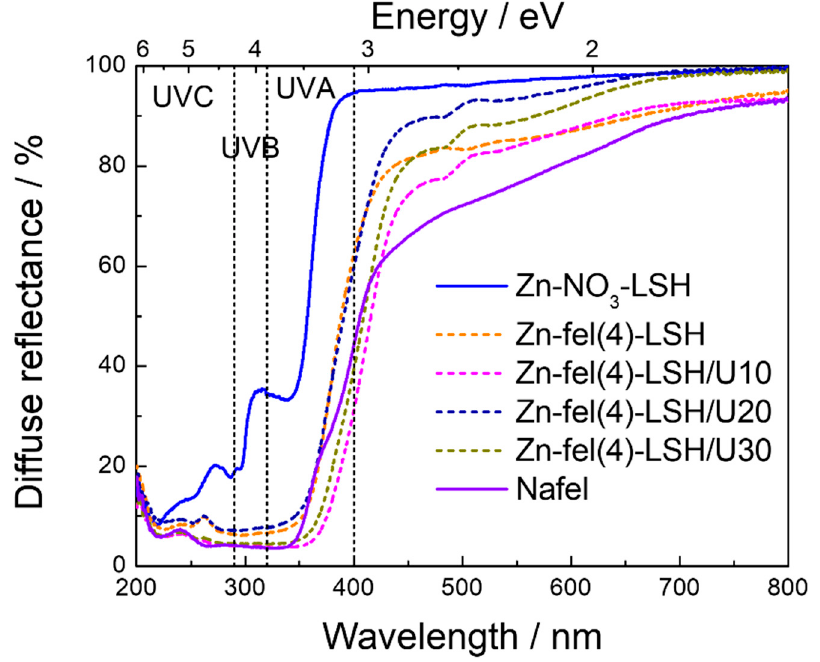
Figure A3. Diffuse reflectance spectra of Zn-NO 3 -LSH, Zn-fel(4)-LSH, Zn-fel(4)-LSH/U10, Zn-fel(4)-LSH/U20, Zn-fel(4)-LSH/U30 and Nafel (NaC 10 H 9 O 4 ) salt.